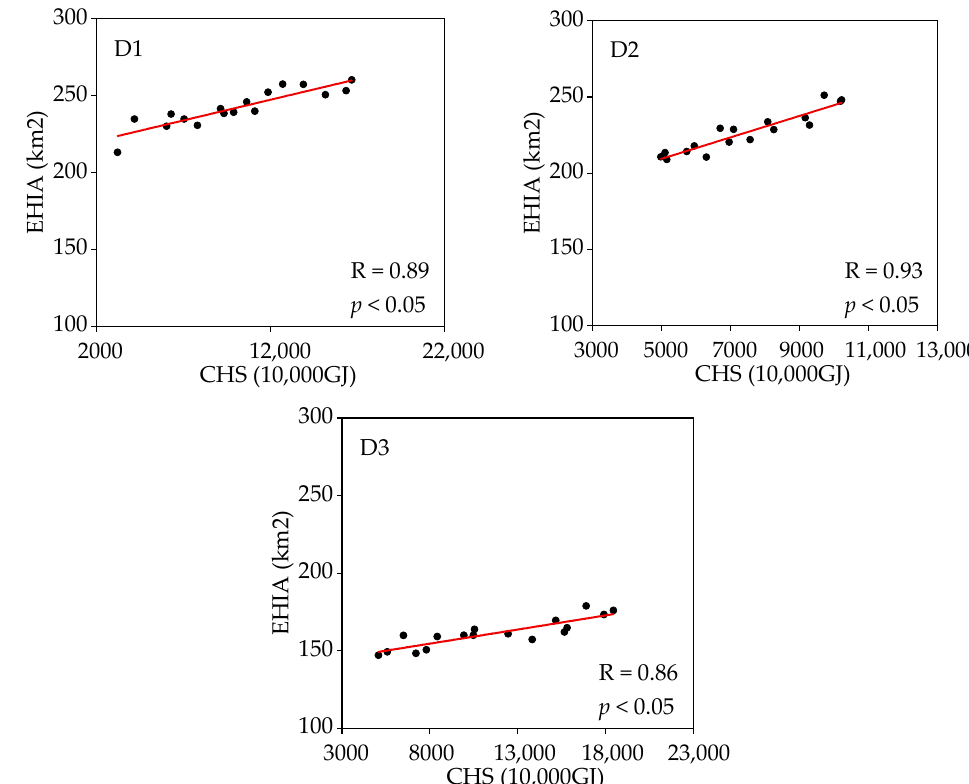
Figure 11. Scatter plot of the central heating supply (CHS) and equivalent heat island area (EHIA).